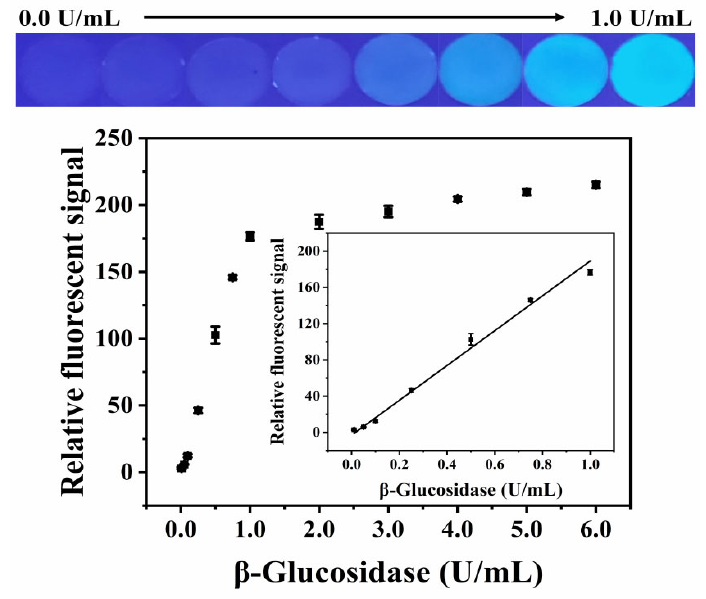
Figure 6. The relative fluorescent value of the paper-based device changed with the activity of β -glucosidase. Inset: calibration plot in the linear range of 0.01–1.00 U/mL. Photographs: fluorescent images of paper ‐ based device at different β‐ glucosidase activity.